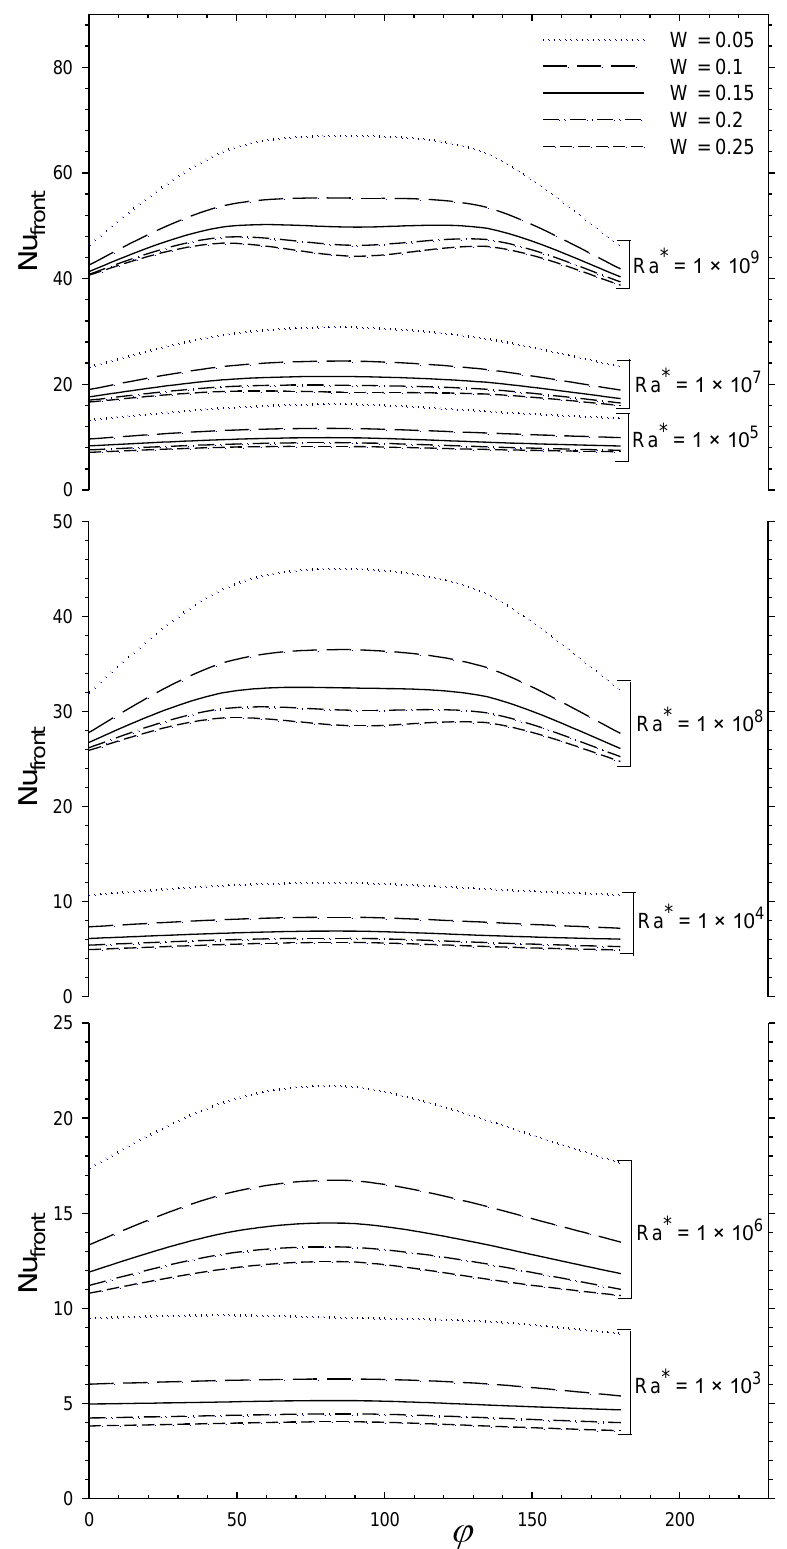
Figure 12. Variations in the mean Nusselt number for the front of a slender cuboid with inclination φ for different Ra * and W .